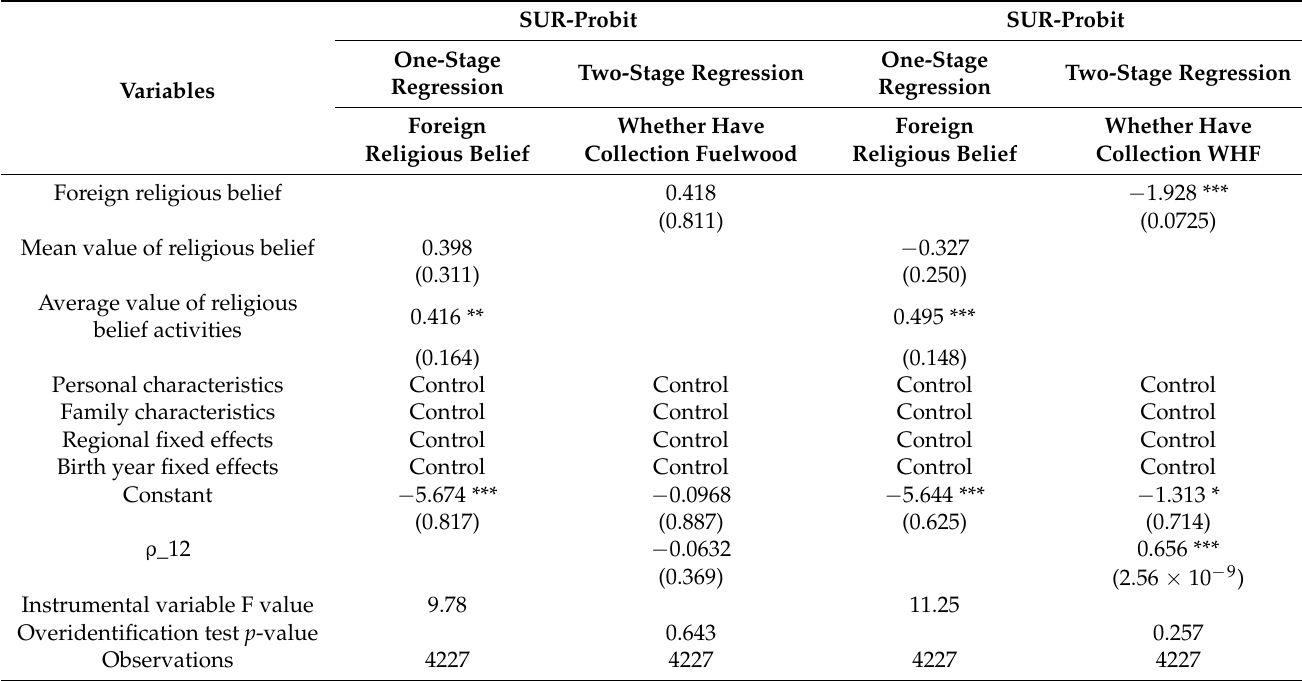
Table 11. Baseline Regression for Foreign Religious Belief and Different NTFPs Collection